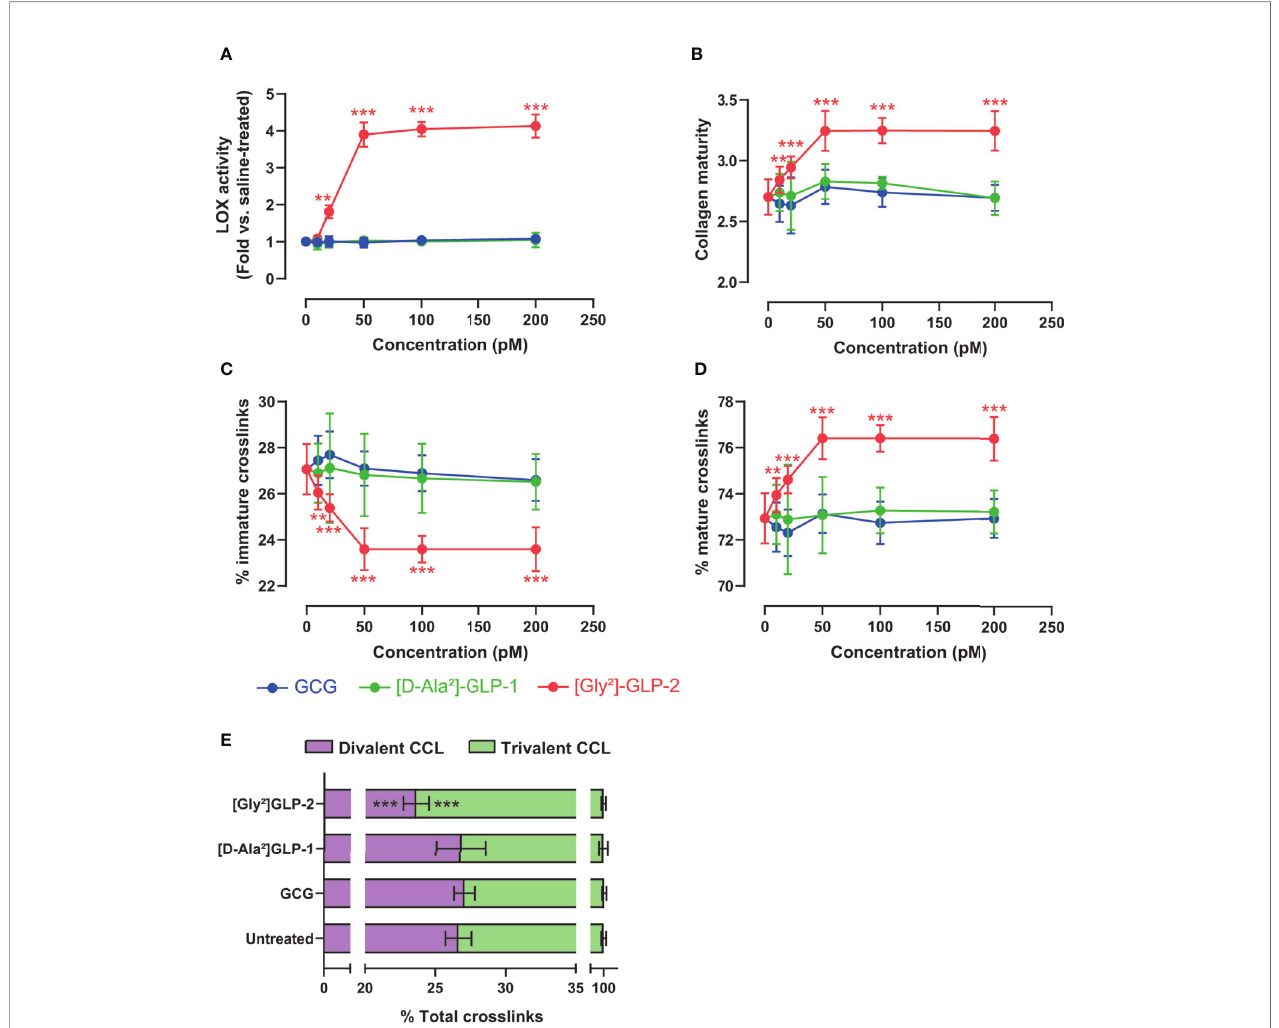
FIGURE 2 | Proglucagon-derived peptides and collagen matrix quality. (A) Lysyl oxidase activity and (B) collagen maturity, expressed as the ratio of mature trivalent/ immature divalent collagen crosslinks, are dose-dependently increased in the presence of [Gly²]-GLP-2, but not GCG or [D-Ala²]-GLP-1. (C) Percentage of immature and (D) mature collagen crosslinks in the extracellular matrix. (E) Normalized enzymatic collagen crosslinking in the extracellular matrix at 50 pM. ** p < 0.01 and *** p < 0.001 vs . untreated